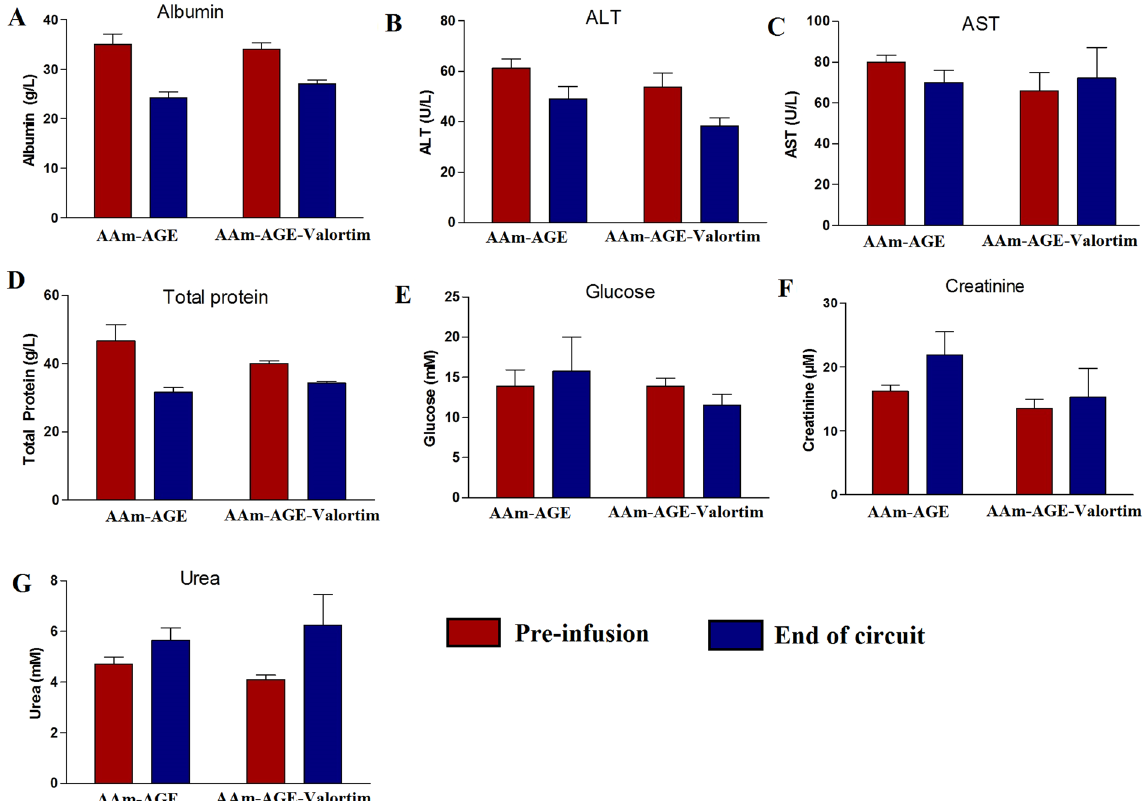
Figure 6. Biochemical analysis results of ( A ) albumin, ( B ) ALT, ( C ) AST, ( D ) total protein, ( E ) glucose, ( F ) creatinine, and ( G ) urea concentrations in rat blood measured before PA IV infusion and at the end of the circuit. No statistically significant differences were